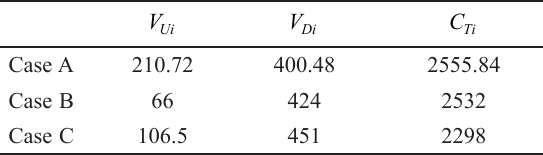
Table 1. Results of pilot study based on actual